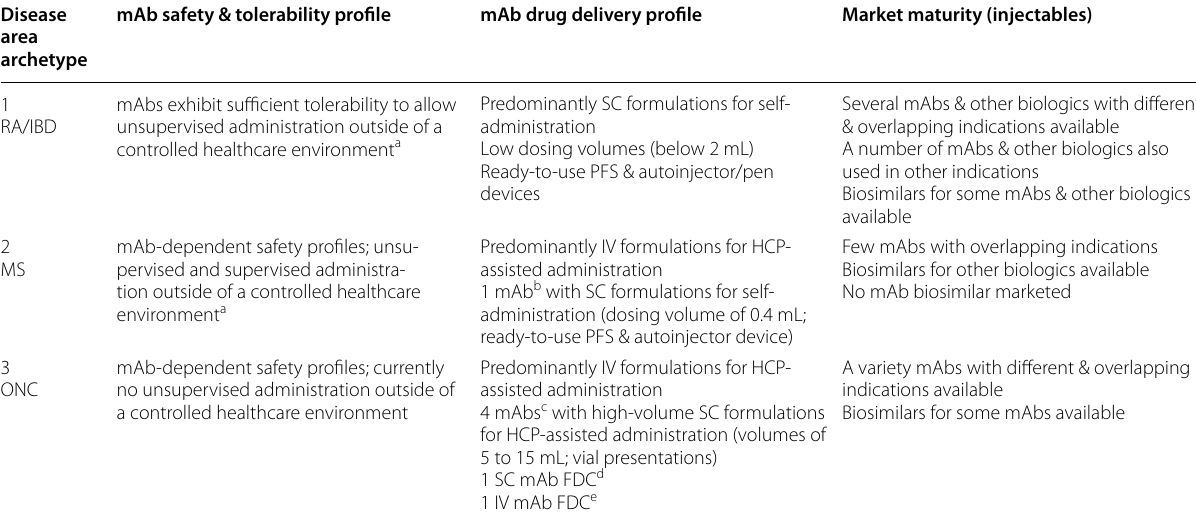
Table 1 Key attributes of selected disease area archetypes; considers marketed mAb profiles